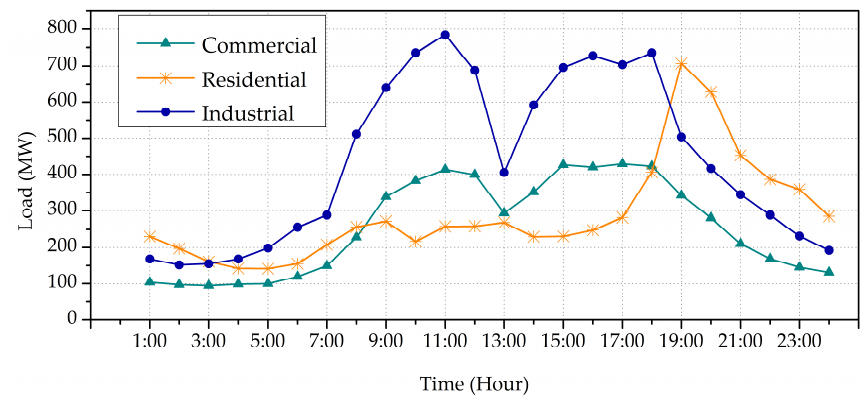
Figure 1. Reference load profiles.